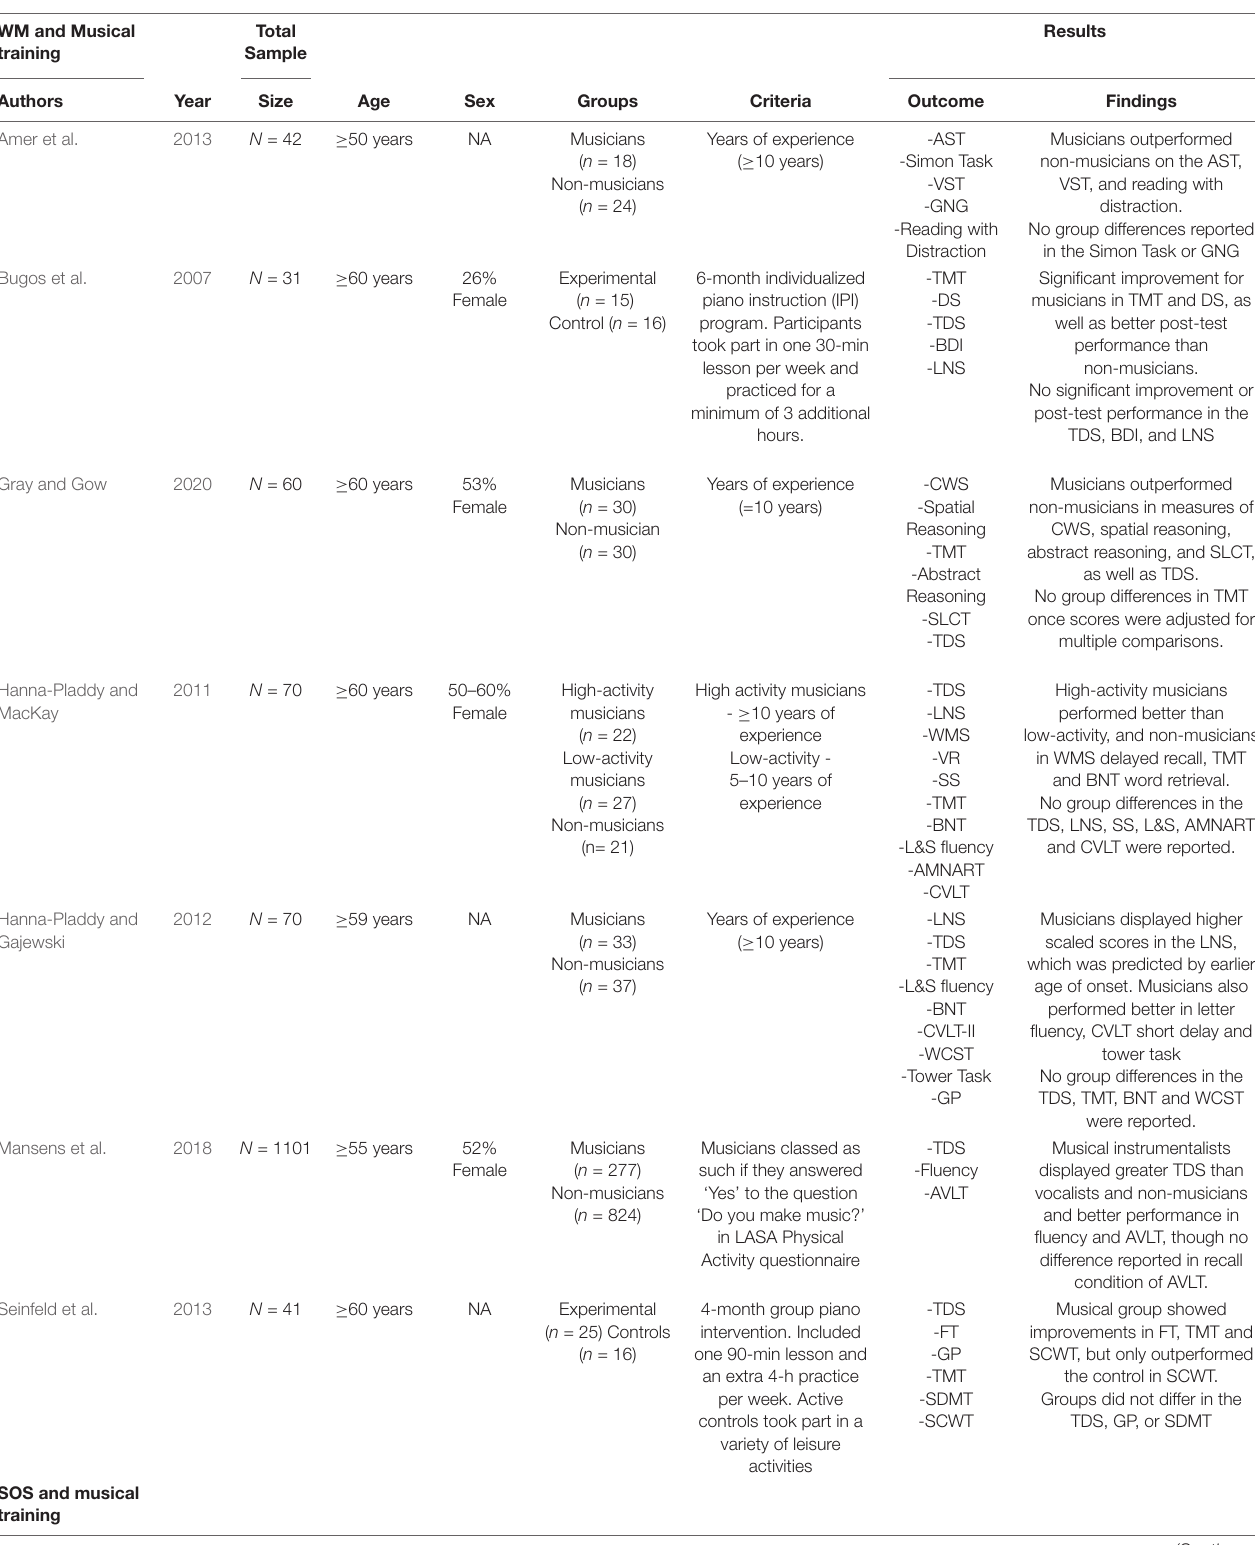
TABLE 1 | Overview of selected literature organized by